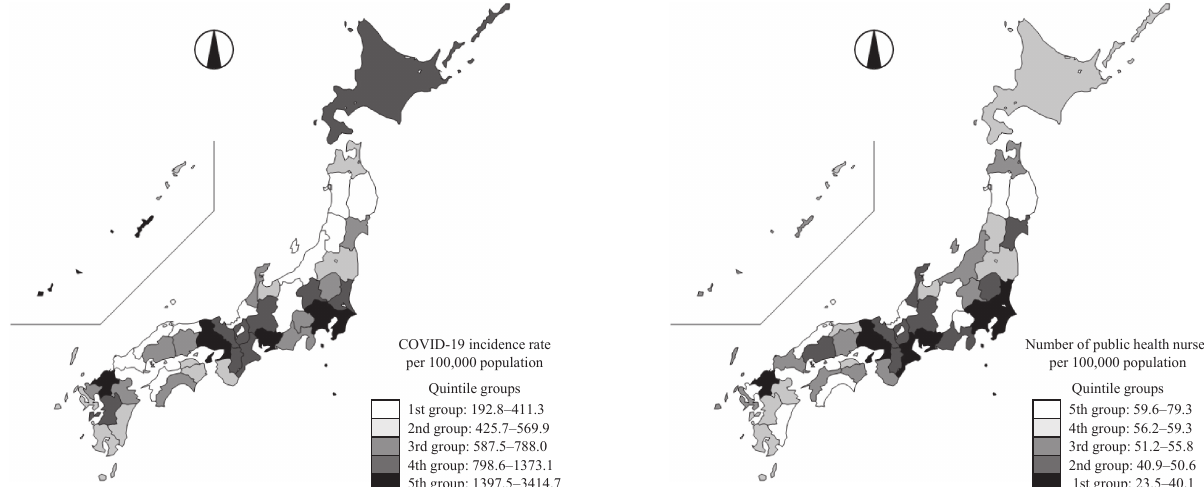
Fig. 1 Color-coded map of COVID-19 incidence rate and the number of PHNs in 47 Prefectures, Japan. PHNs; public health nurses. For the color settings, black is high risk and white is low risk. That is, high risk (i.e., black) means that the COVID-19 incidence rate is high and the number of public health nurses is small. COVID-19 incidence rate is based on all COVID-19 cases from January 16, 2020 to the end of September 2021. The number of public health nurses per 100,000 population is based on the 2018 survey